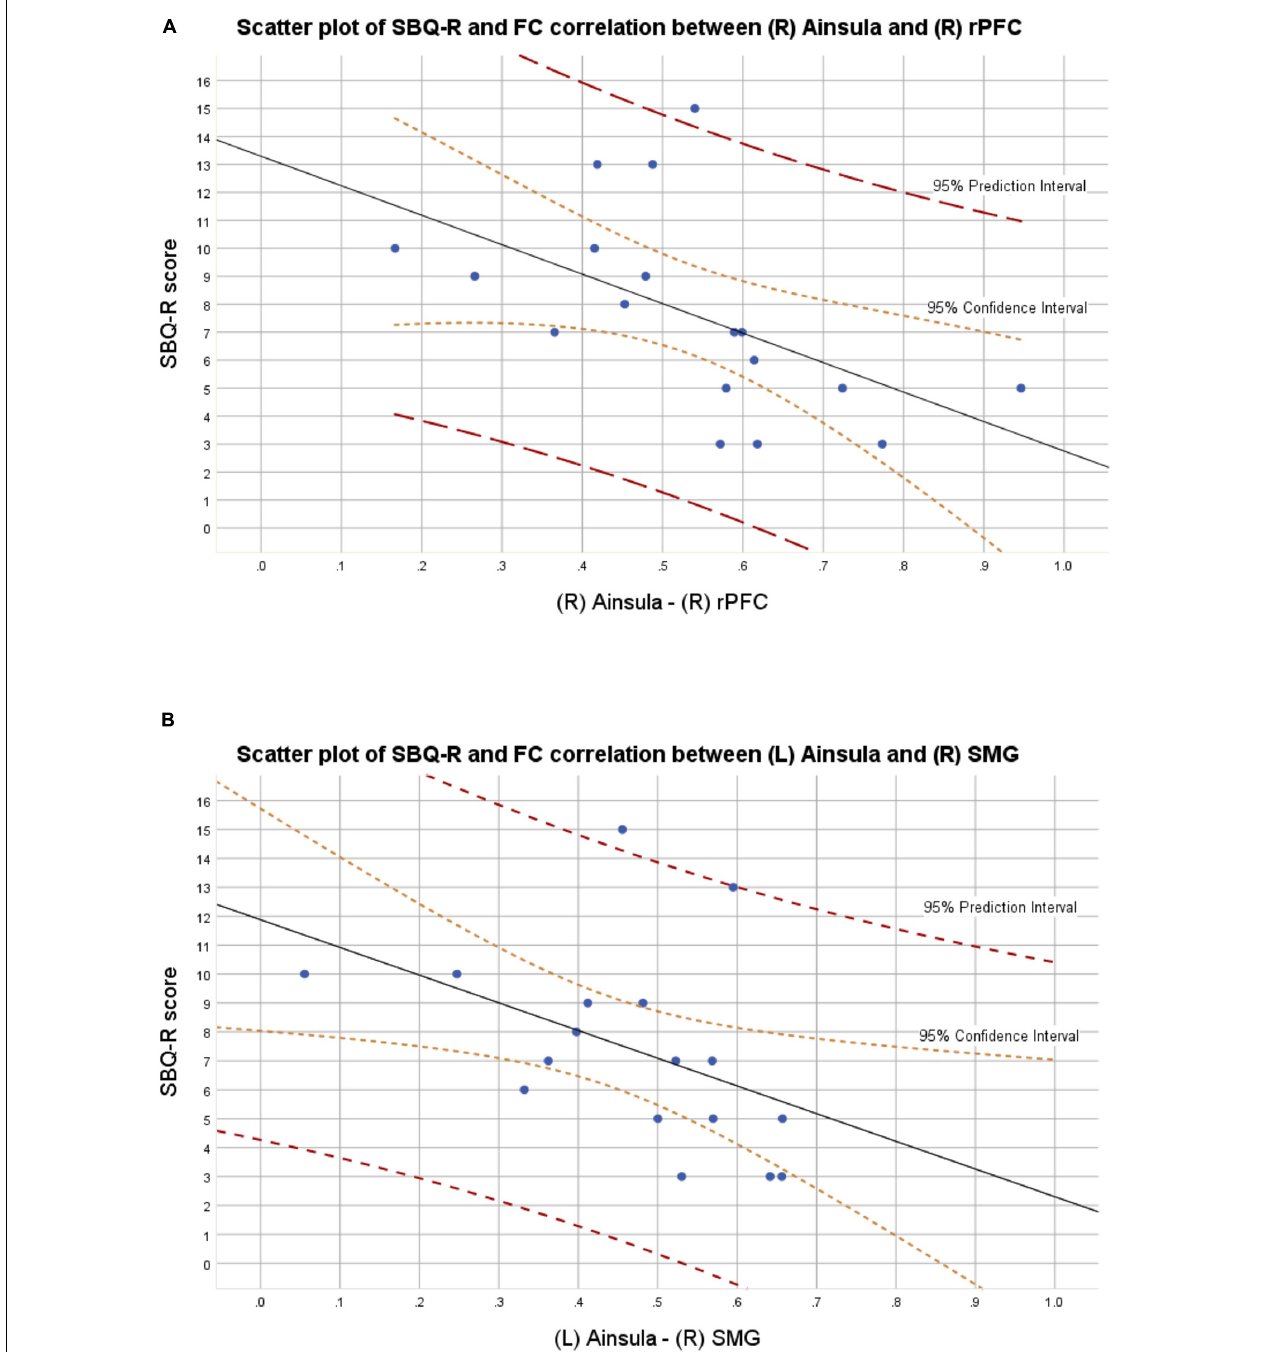
FIGURE 2 | (A) Scatter plot with confidence and prediction intervals showing association between SBQ-R scores and raw functional connectivity values between right insula and right rostral prefrontal cortex in euthymic BD patients. (B) Scatter plot with confidence and prediction intervals showing association between SBQ-R scores and raw functional connectivity values between left insula and right supramarginal gyrus in euthymic BD patients.